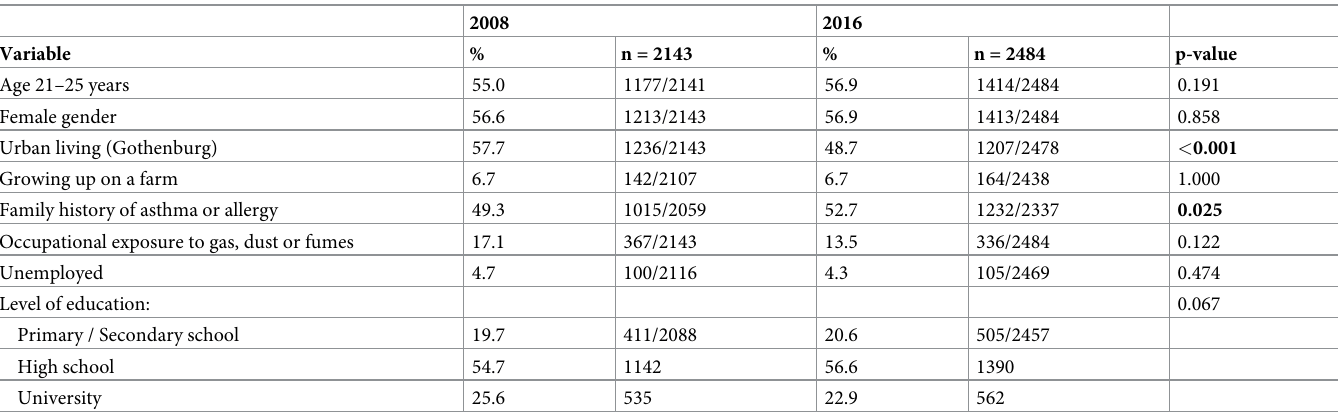
Table 1. Characteristics of the study population in 2008 and 2016.